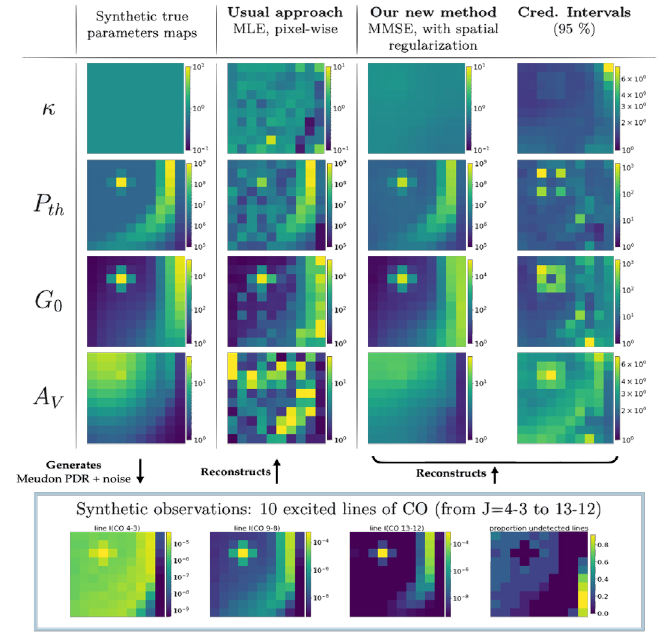
Figure 3. Scatter plots